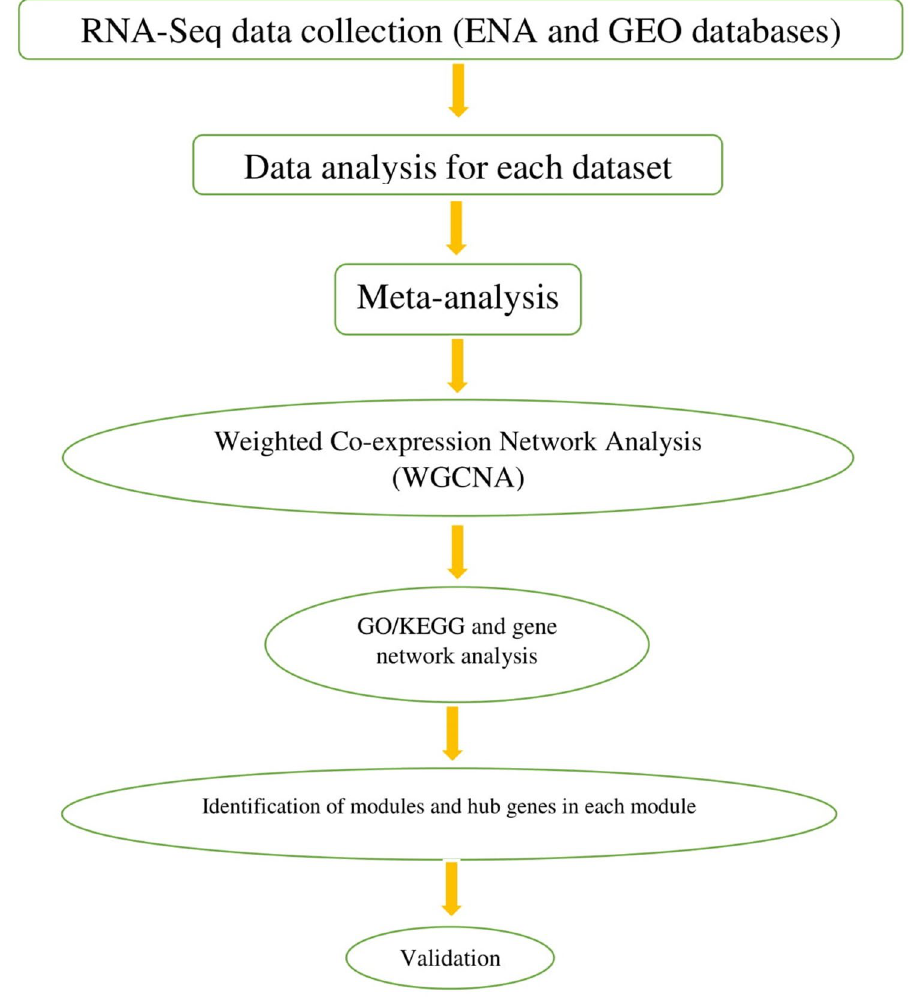
Figure 8. Flowchart of the performed meta-analysis and WGCNA analysis of the lactation process using the RNA-Seq